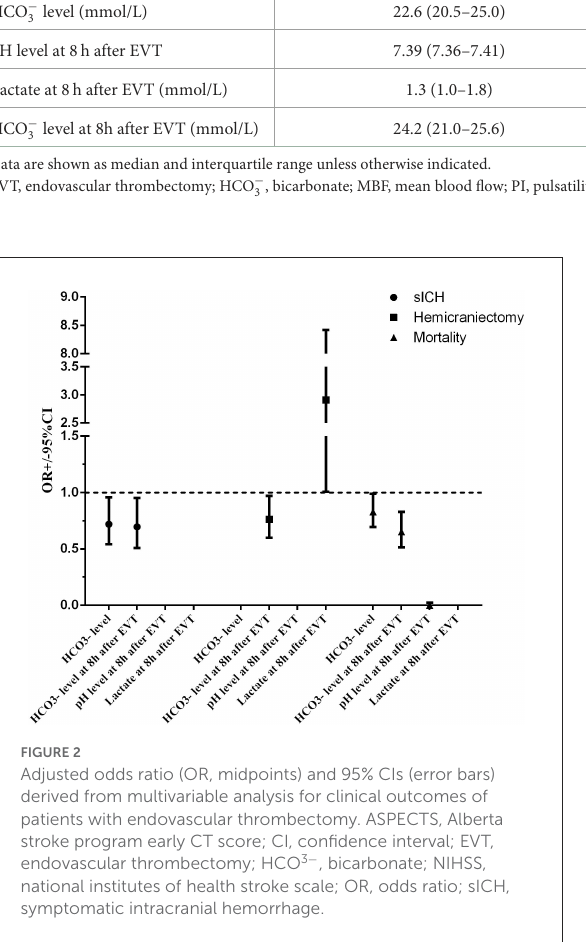
(Table 5). Adjusting diabetes mellitus, NIHSS score, ASPECTS, tandem occlusion, onset-to-groin puncture time, and decreased HCO − levels were independent predictors of mortality within 3 3 months in the multivariable analysis (OR = 0.829, 95% CI: after EVT (OR = 0, 95% CI: 0–0.022, P = 0.015) and decreased